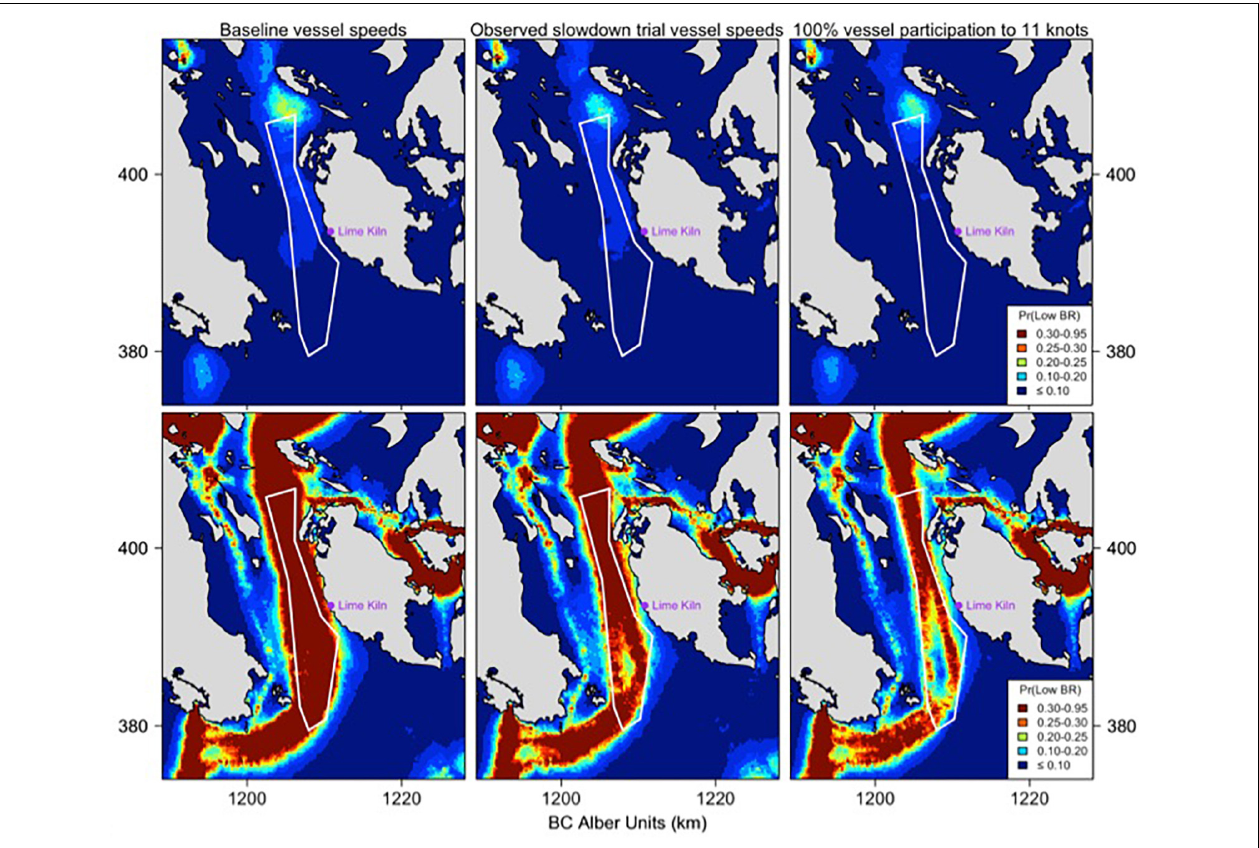
FIGURE 6 | The top panels are the spatially indexed probability of observing a low behavioral response, or Pr(Low BR), by applying the dose-response function to the ‘median’ (p50%) broadband noise level for an average day, under scenarios 1, 2, and 3. The bottom panels are the spatially indexed probability of observing a Low BR given the noisiest 95th percentile (p95%) of the daily broadband noise-exposure under the same three scenarios (1, 2, and 3). If SRKW were uniformly distributed across the region, we would expect the Pr(Low BR) to be related to the color scale of these maps. The three panels represent the different speed scenarios within the slowdown region with Baseline speeds on the left, observed participation in the center, and 100% participation to 11 knots depicted on the right panel. Note that the same color scale is used for all map panels, and the Slowdown trial boundary is represented by the white polygon